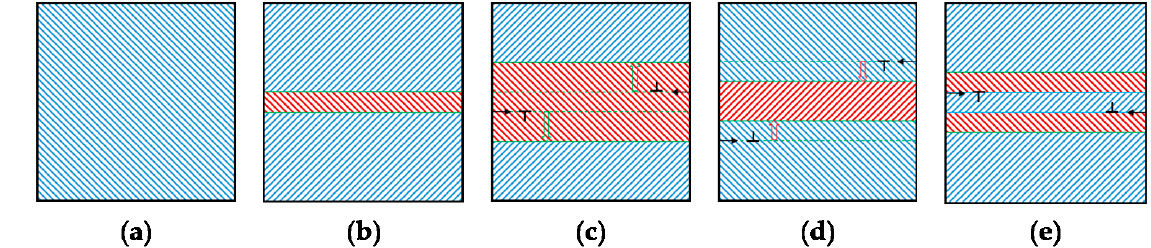
Figure 9. Deformation twinning and detwinning operations: ( a ) Initial twin-free parent grain ( b ) Operation A : As soon as the twin volume reaches a threshold of f 0 , twin nucleation occurs. This nucleated twin can grow according to the reduction in the volume of parent grain. ( c ) Operation B : The growth of the twin region can occur according to the child propagation. ( d ) Operation C : As the parent region grows, the twin volume reduces. ( e ) Operation D : Detwinning inside the twinned child leads to the twin volume reduction (After Yaghoobi et al. [9]).